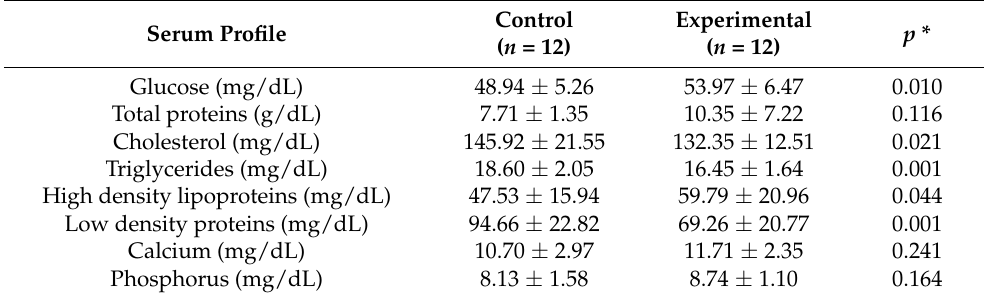
Table 3. Serum chemistry profile of control and experimental SOD-rich melon supplement group of Tuj lambs. Serum